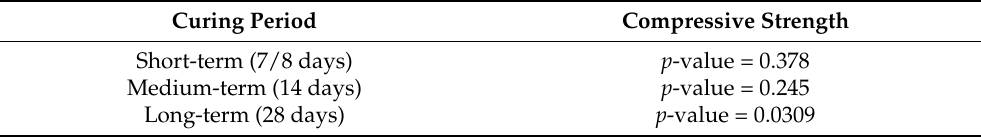
Table 10. The p- values of the F-tests performed with the values of the compressive strength for different curing periods.